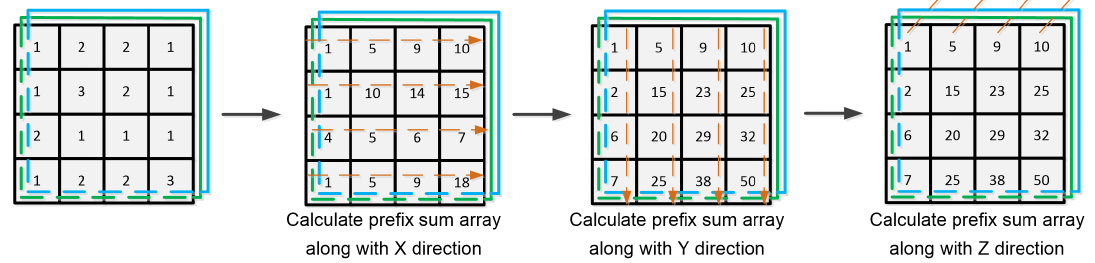
Figure 2. An illustration of calculating the 3-D sum-table under the GPU parallel computing